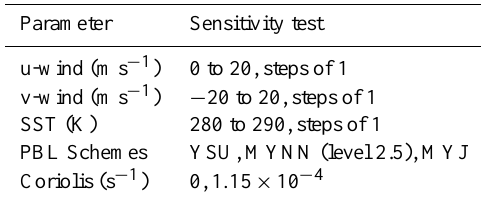
Fig. 7. Daytime evolution of PBL height (red) and 2m specific hu- midity (blue) for the baseline single coast simulation using the YSU PBL scheme and an SST of 287K. Solid lines indicate values 150km onshore and dashed lines are at the coastline. Sunrise and sunset times are represented by the solid vertical black lines